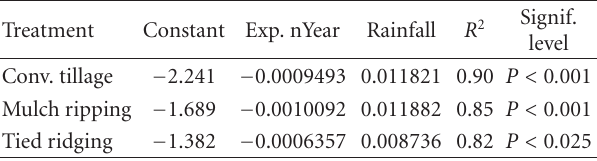
Table 3: The e ff ect of rainfall amount and number of years of cultivation on maize yield under di ff erent tillage systems at Makoholi Contill